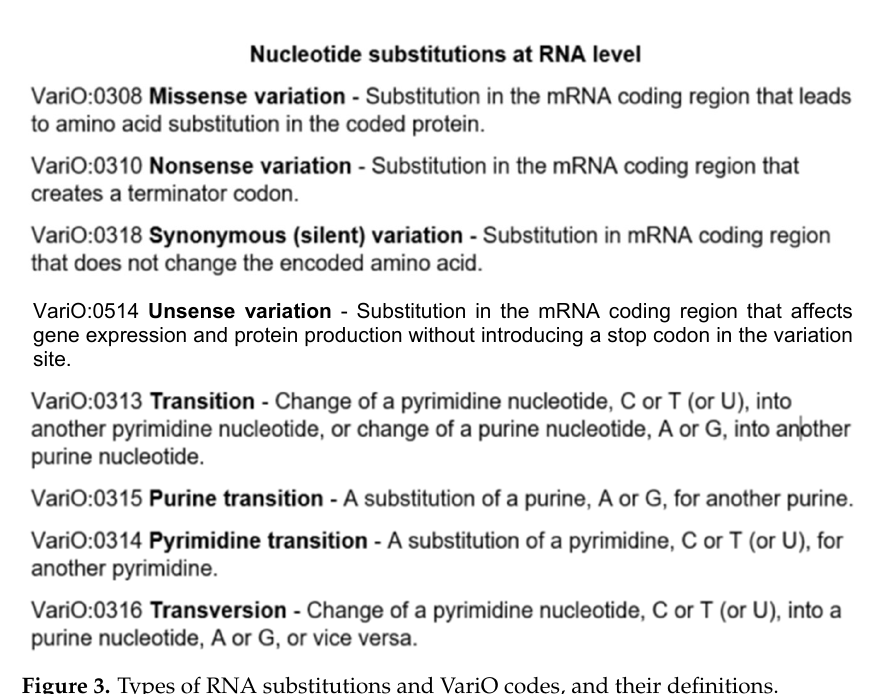
Figure 3. Types of RNA substitutions and VariO codes, and their definitions.